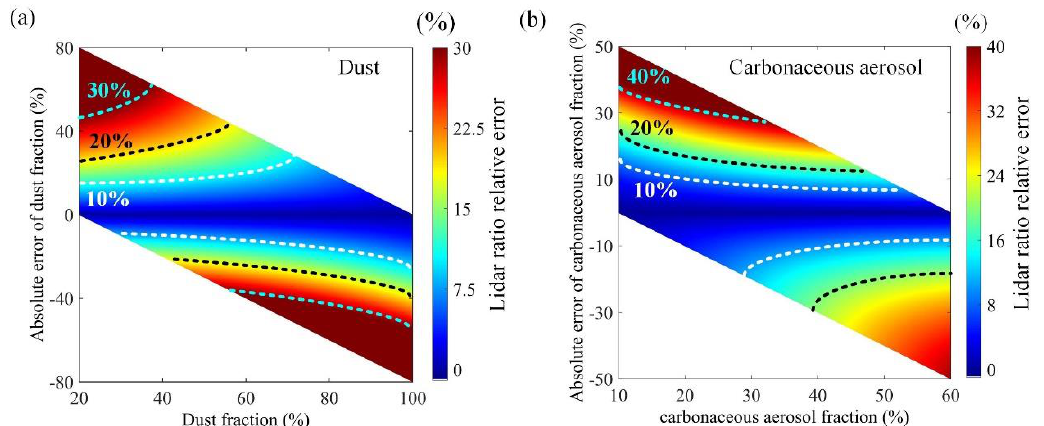
Figure 10. The relationship between the two absorbing aerosol fractions and the lidar ratio relative error. The horizontal and vertical coordinates represent the actual value of the two absorbing aerosol fractions and the absolute error of the reference value, respectively. The color bar represents the relative error of the lidar ratio calculated after the two absorbing aerosol fractions were input into the LR-AFNR. The white part in the figure represents no data. ( a ) Under the condition of dust, the sky blue, black, and white dotted lines represent the positions where the relative error of the lidar ratio was 30%, 20%, and 10%, respectively; ( b ) Under the condition of carbonaceous aerosol, the sky blue, black and white dotted lines represent the positions where the relative error of the lidar ratio was 40%, 20%, and 10%, respectively.